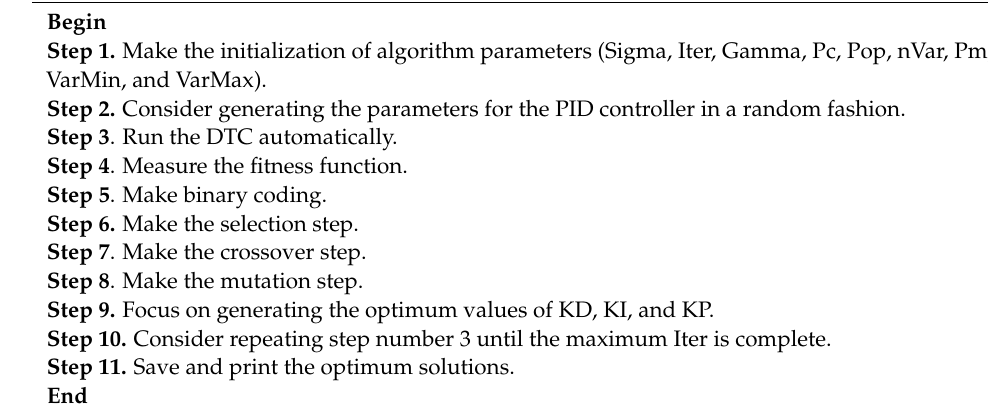
Algorithm 1: Genetic